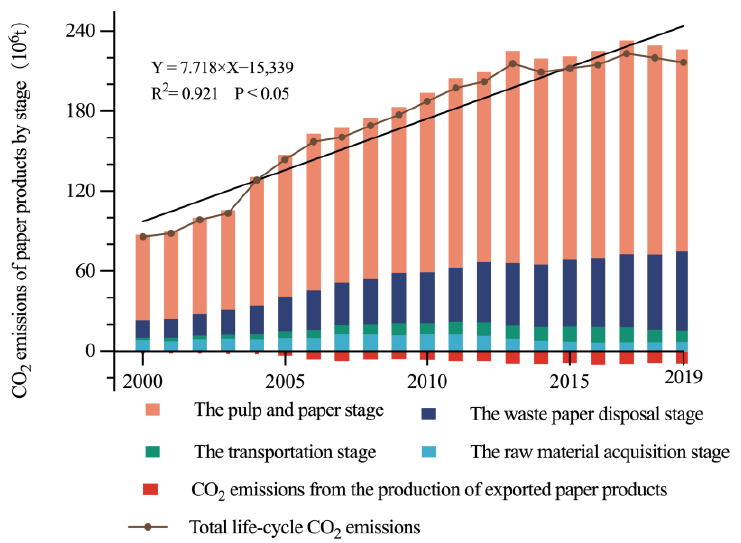
Figure 2. CO 2 emissions from the life cycle of paper products from the perspective of consumer responsibility.